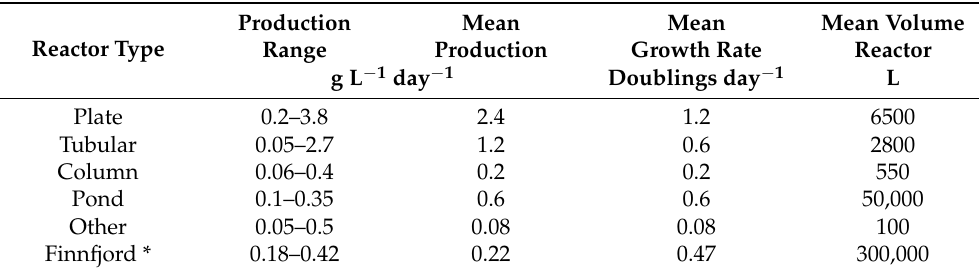
Table 12. Production, growth rates and volumes of selected photobioreactor types. Numbers in table are rounded and growth rates are in most of the instances computed from reported increases in biomass in these publications [117–138]. Values are (assumed) DW